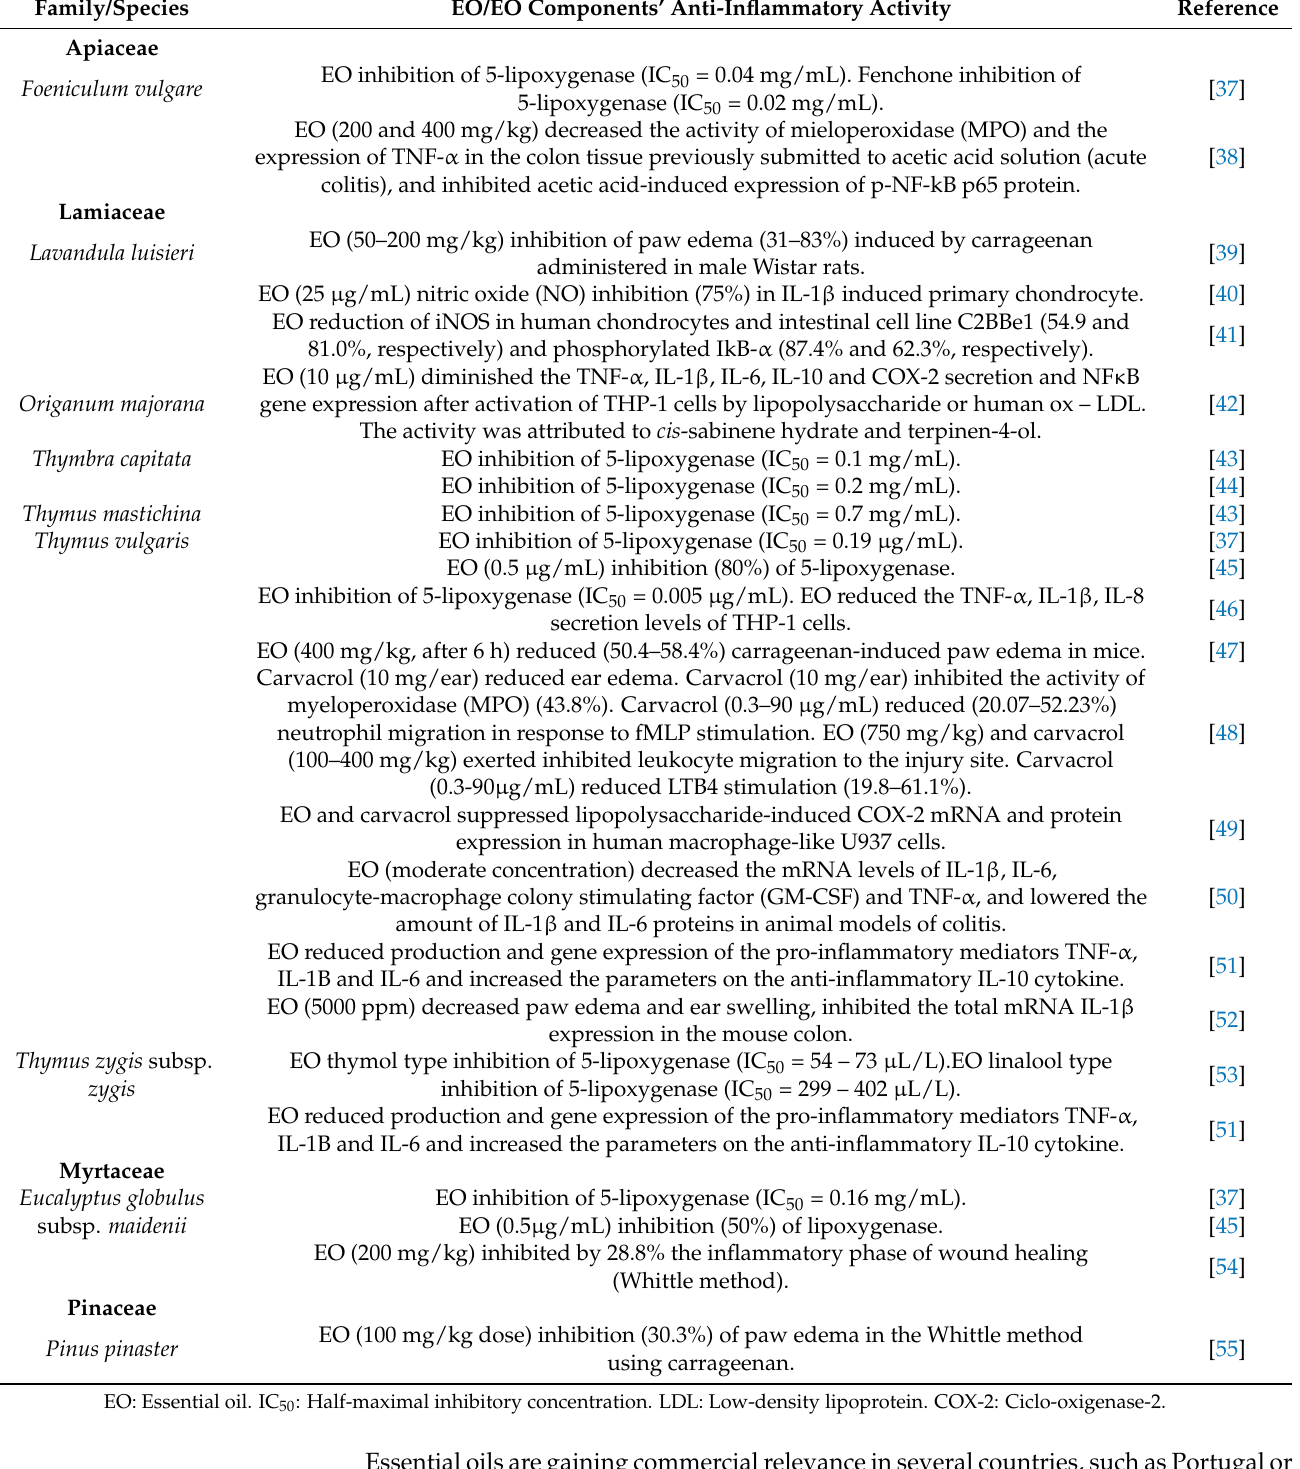
Table 2. Previously reported anti-inflammatory activity of the essential oils (EOs) from the species under study.